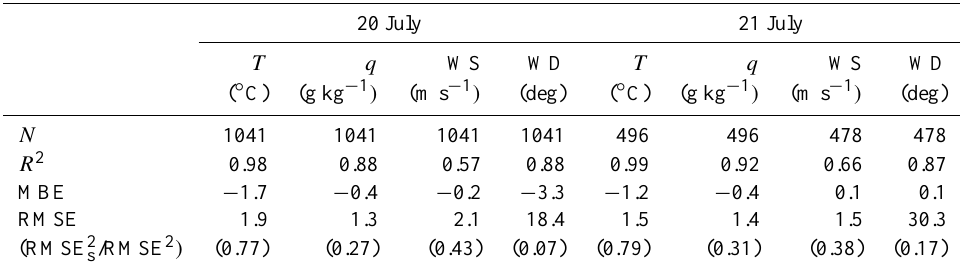
Table 2. Statistics from the comparison of WRF-Chem simulation with the WP-3D measured meteorology. T , q , WS, WD represent air temperature, specific humidity, wind speed, and wind direction, respectively. Positive values of MBE in wind direction stand for a clockwise bias from the observed wind direction.